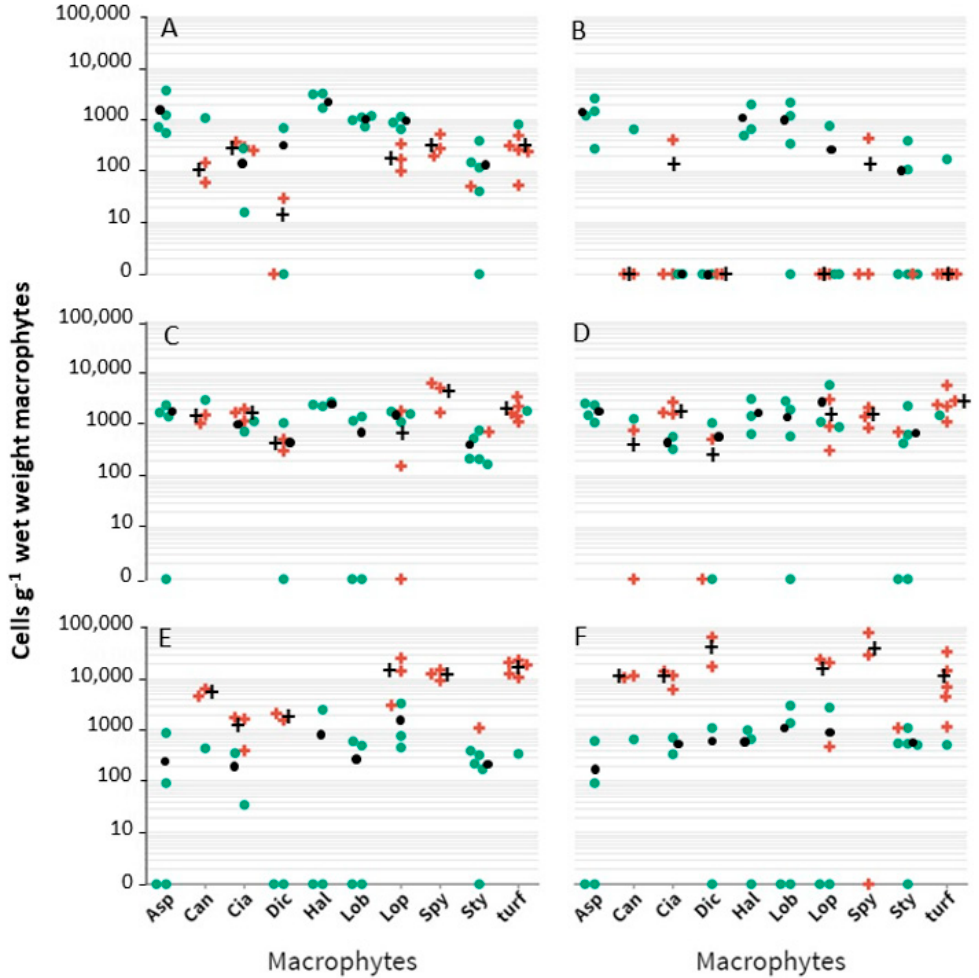
Figure 3. Abundances of the di ff erent dinoflagellate genera in di ff erent macrophytes from the two stations, Cotillo (circles, each of the sample value in green and mean values in black) and Playitas (crosses, each of the sample value in red and mean values in black). Gambierdiscus ( A ), Sinophysis ( B ), Prorocentrum ( C ), Coolia ( D ), Ostreopsis ( E ), Vulcanodinium ( F ). See macrophyte codes in Table